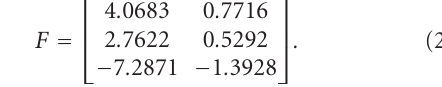
Algorithm 7 after 5 iterations, an SOF gain F is found